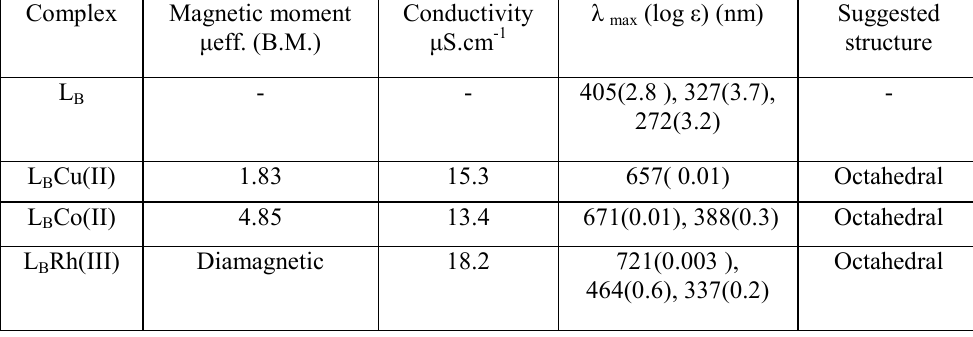
Table 3. Magnetic moments, Conductivity and Suggested Structures for Complexes in (10 -3 M) DMSO solvent.